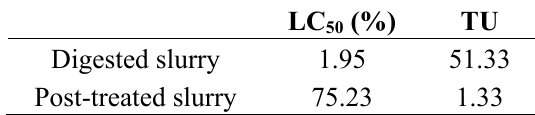
Table 3. Effect on larvae exposed to digested and post-treated slurry.